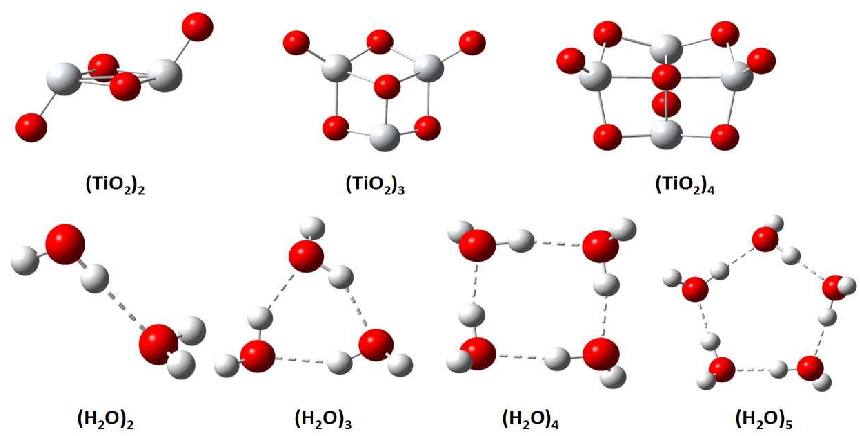
Figure 1. Equilibrium structure of (TiO 2 ) n and (H 2 O) n clusters . Table 1. Binding energy per molecule (kcal/mol) of (TiO 2 ) n ( n = 2–4) clusters evaluated